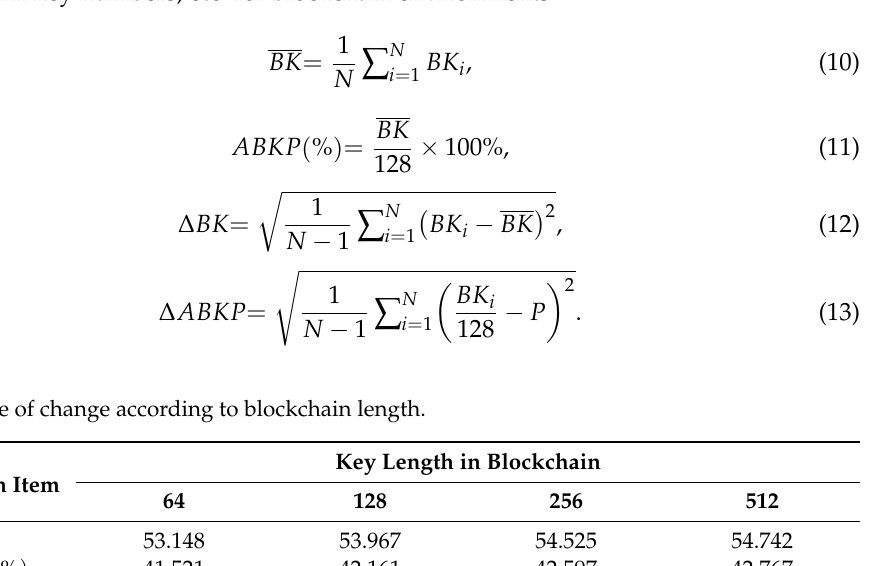
Number of IoT Info.